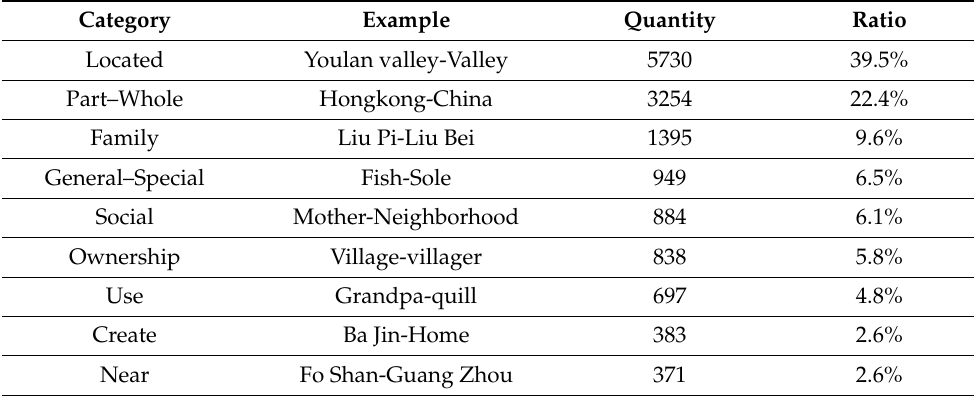
Table 3. The set of relation